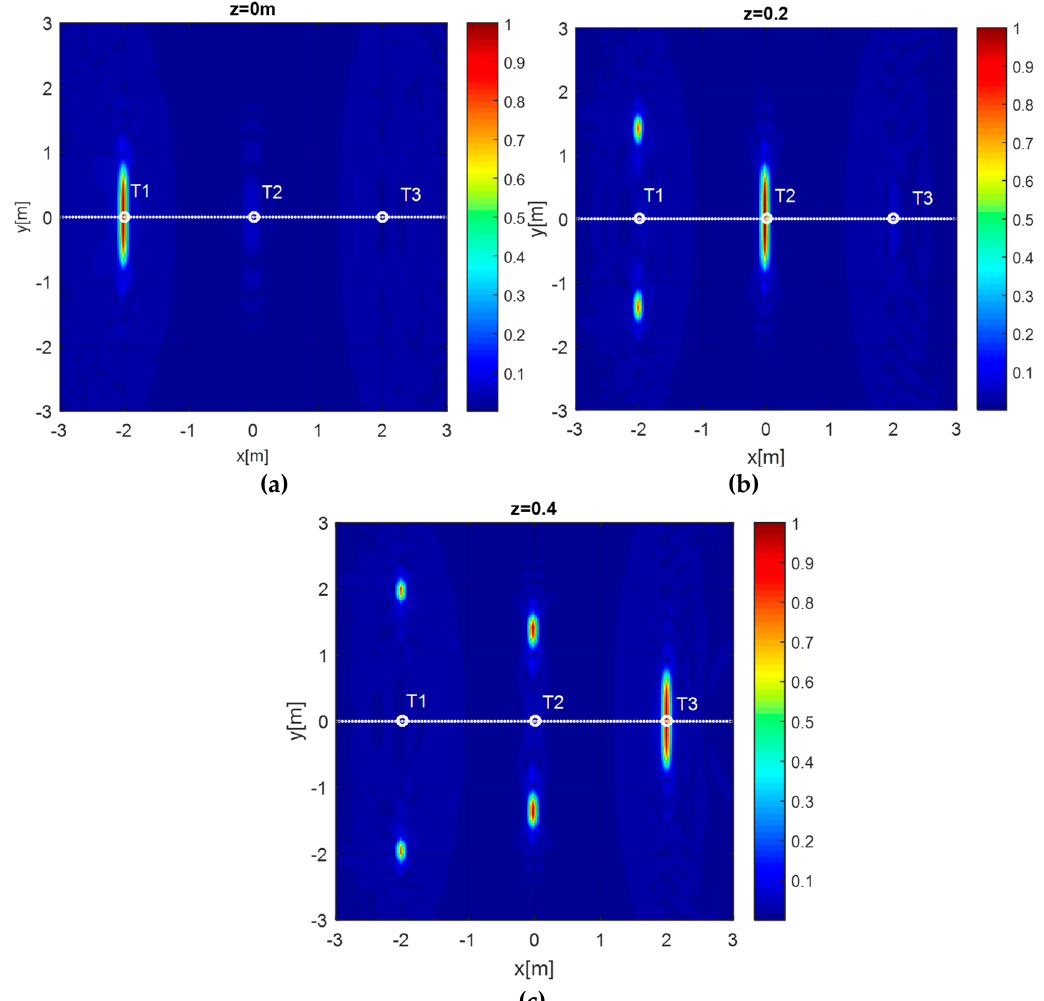
Figure 14. Reconstruction results in a three-target scenario ( a ) image plane at z = 0 m; ( b ) image plane at z = 0.2 m; ( c ) image plane at z = 0.4 m. Table 5. Estimated and true target positions for different imaging planes.